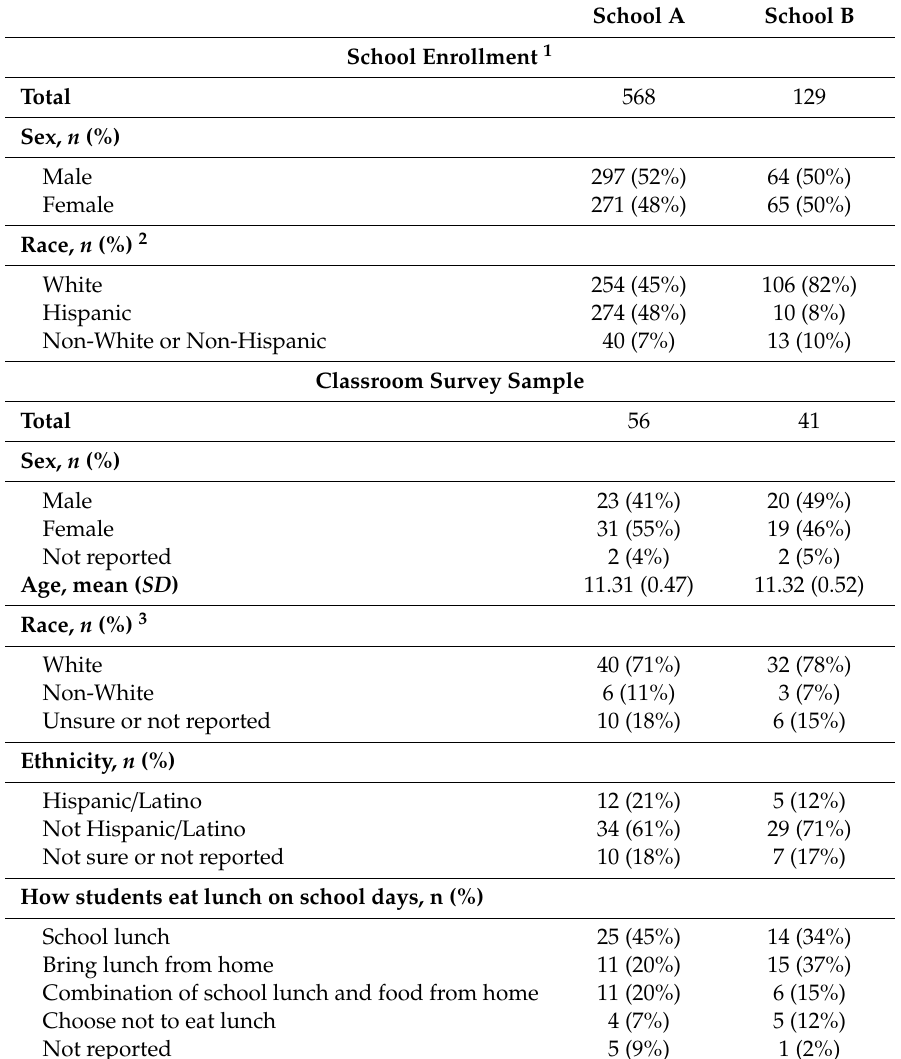
Table 1. Demographic characteristics of intervention schools ( n = 2) and sample demographics of students participating in the classroom